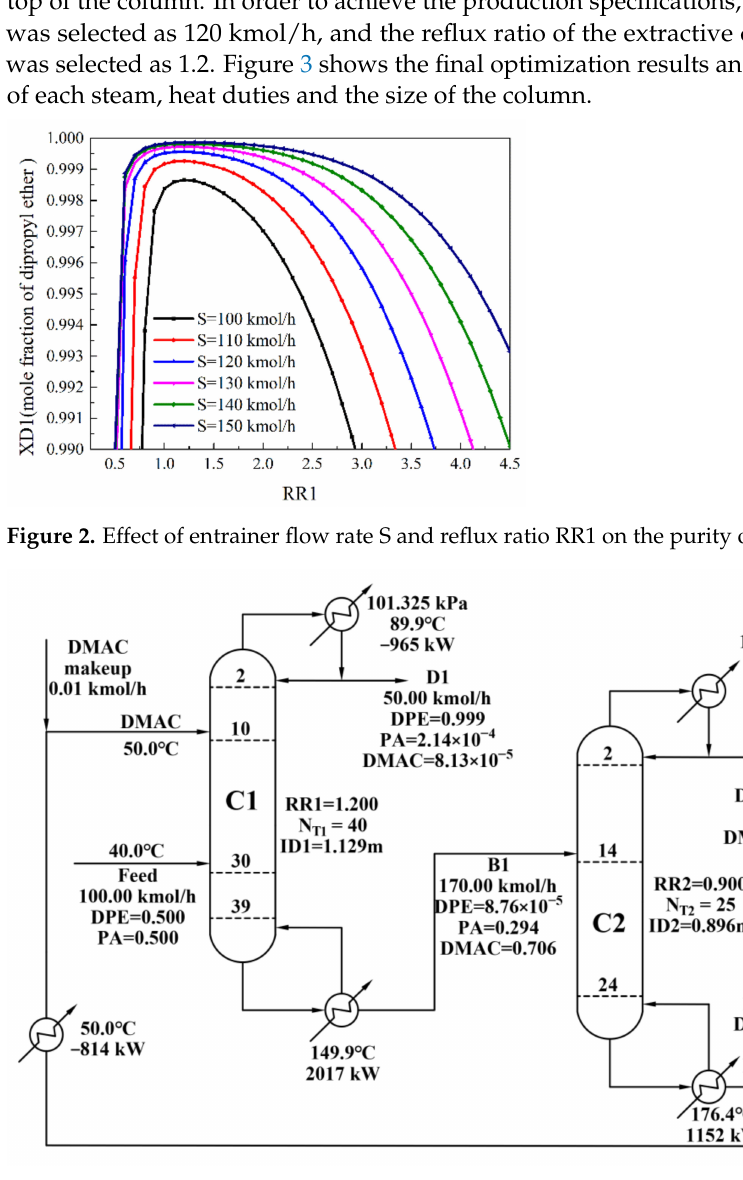
Figure 3. Process flow diagram of the